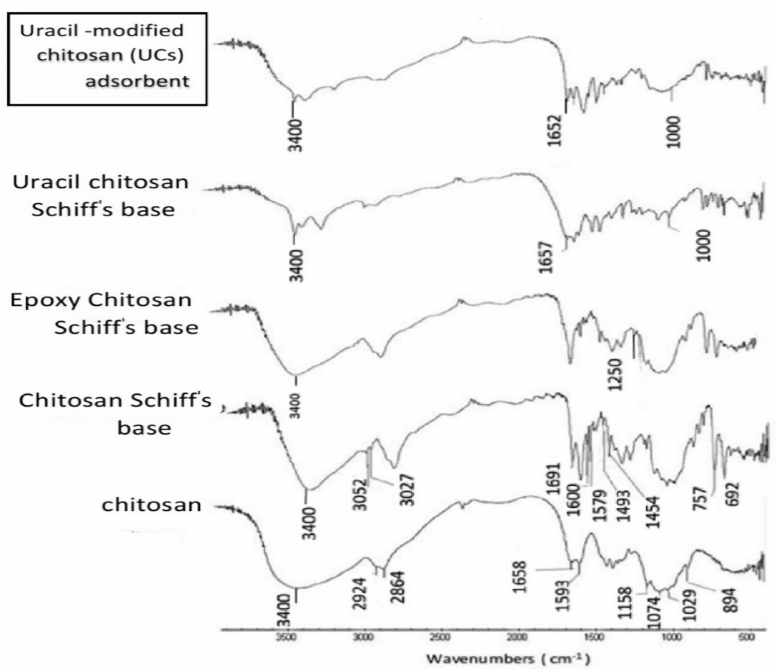
Figure 2. FTIR spectra of the modified chitosan